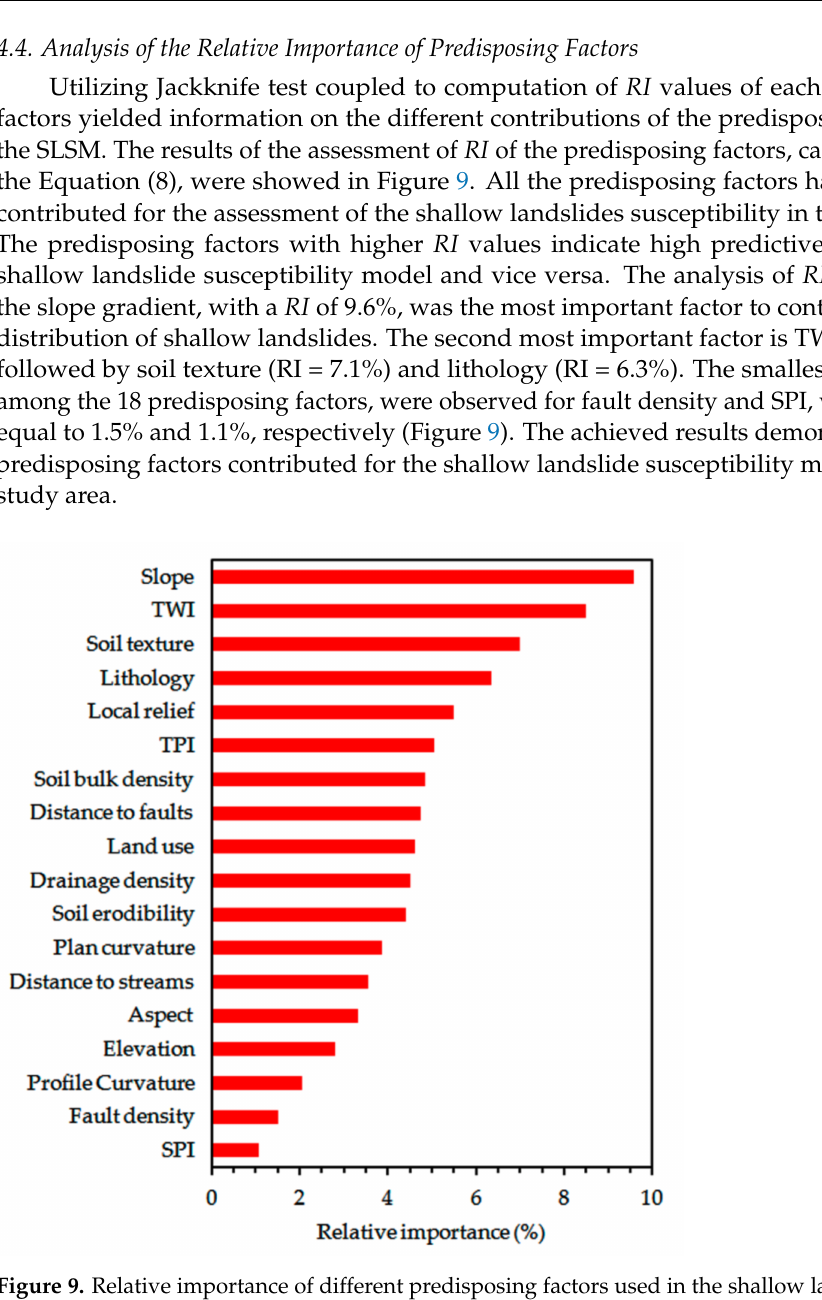
Figure 9. Relative importance of different predisposing factors used in the shallow landslide suscep- tibility